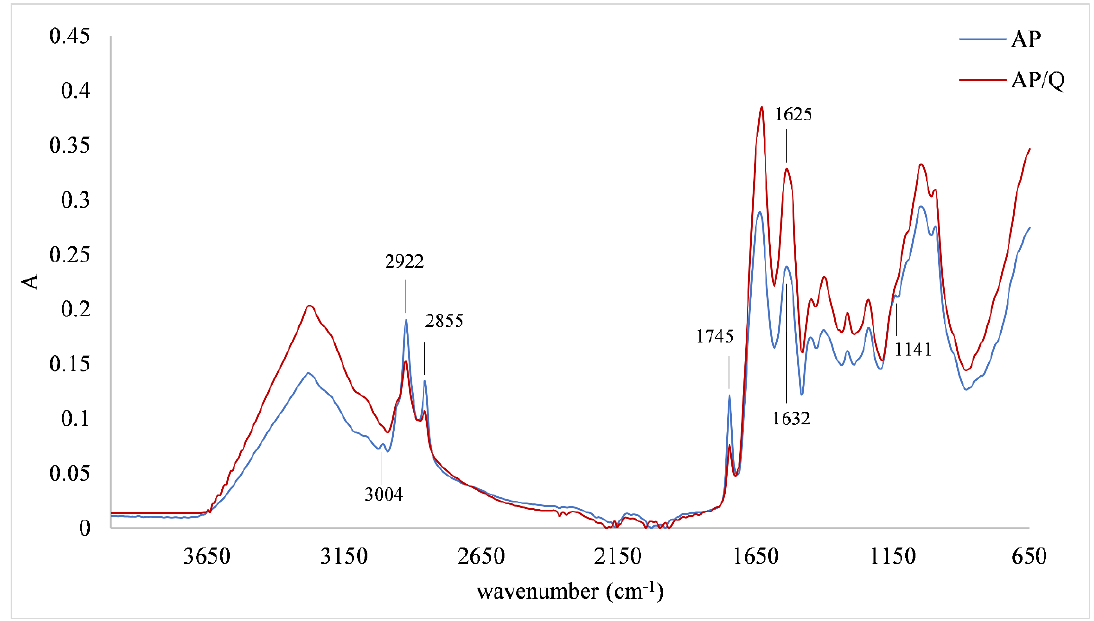
Figure 1. IR spectra of almond protein matrix (AP) and almond protein/quercetin microparticles (AP/Q).